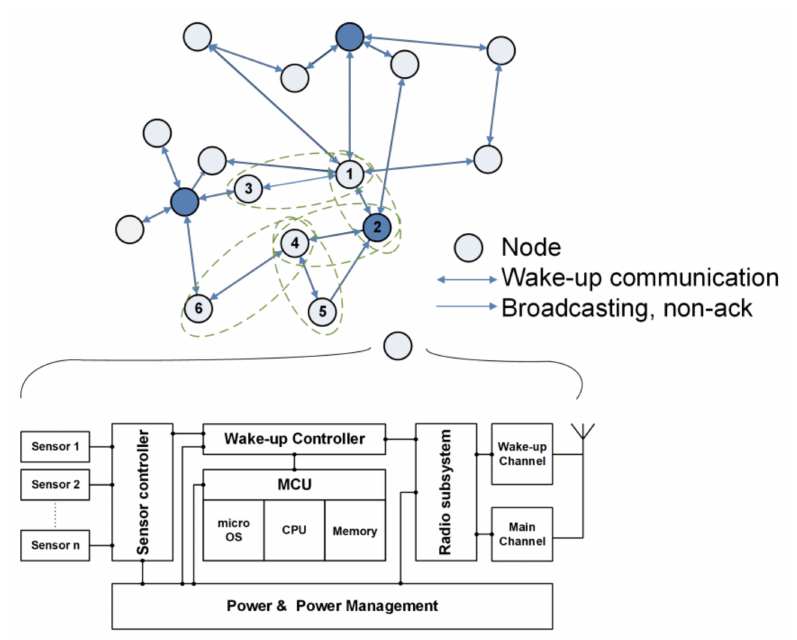
Figure 1. WSN Network connected multiple sensors and hardware block diagram of the sensor node module with a similar architecture to Mica2.